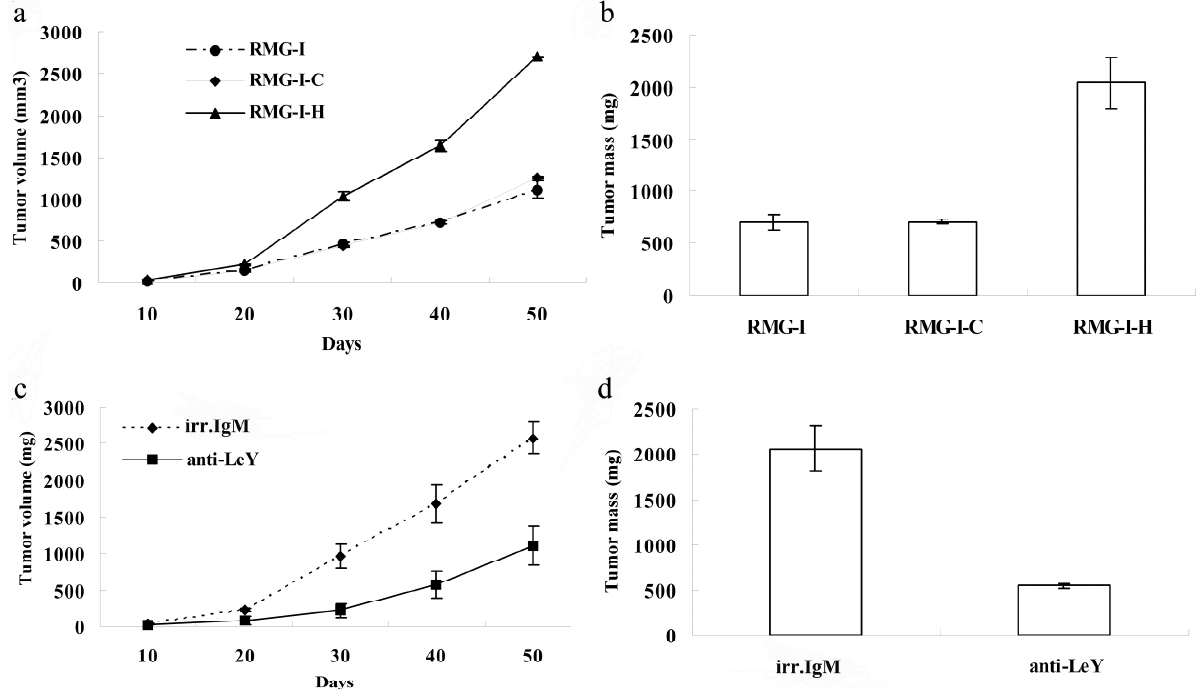
Figure 3. LeY increases tumor growth in nude mice. 15 nude mice divided into 3 groups were injected with RMG-I, RMG-I-C or RMG-I-H cells [10 7 cells/0.3 mL]. During the inhibition assay, LeY mAb and irrelevant IgM antibody treated RMG-I-H cells [10 7 cells/0.3 mL] were subcutaneously injected into nude mice. Tumor volume ( A , B ) and tumor mass ( C , D ) were assessed as mentioned in the Materials and Methods section.